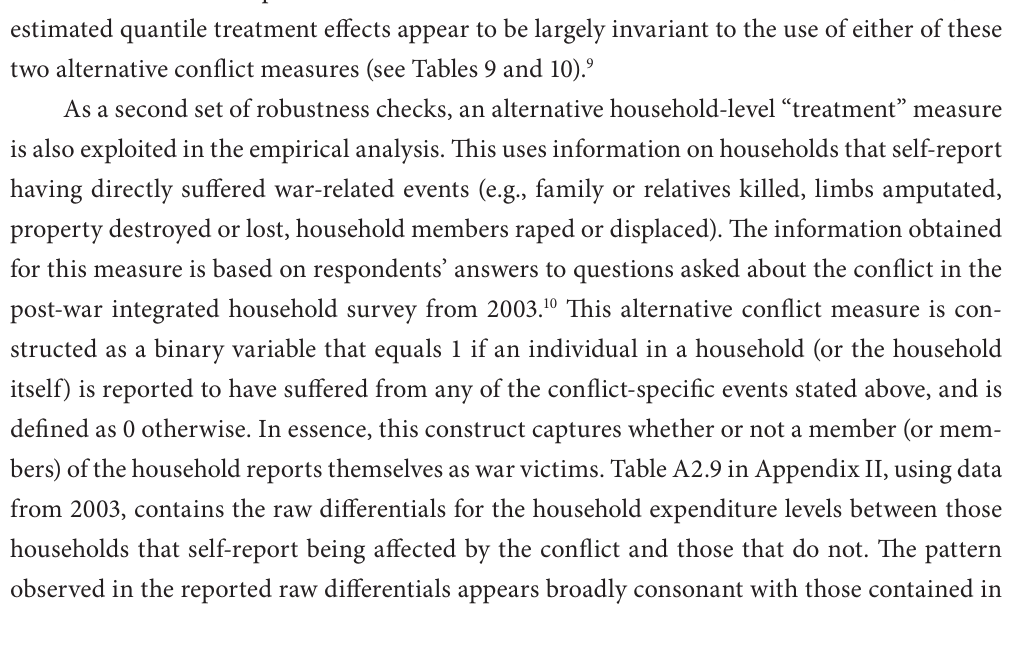
OLS and Quantile Treatment Effects using Log Household Expenditure – Conflict Exposure using Conflict Deaths per Chiefdom Above the Median